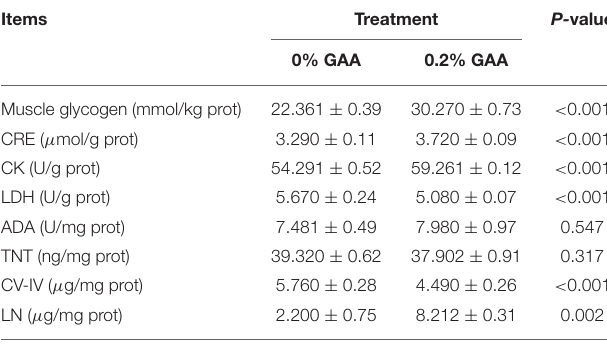
TABLE 7 | Effects of dietary GAA on biochemical metabolites in the meat of Jinjiang